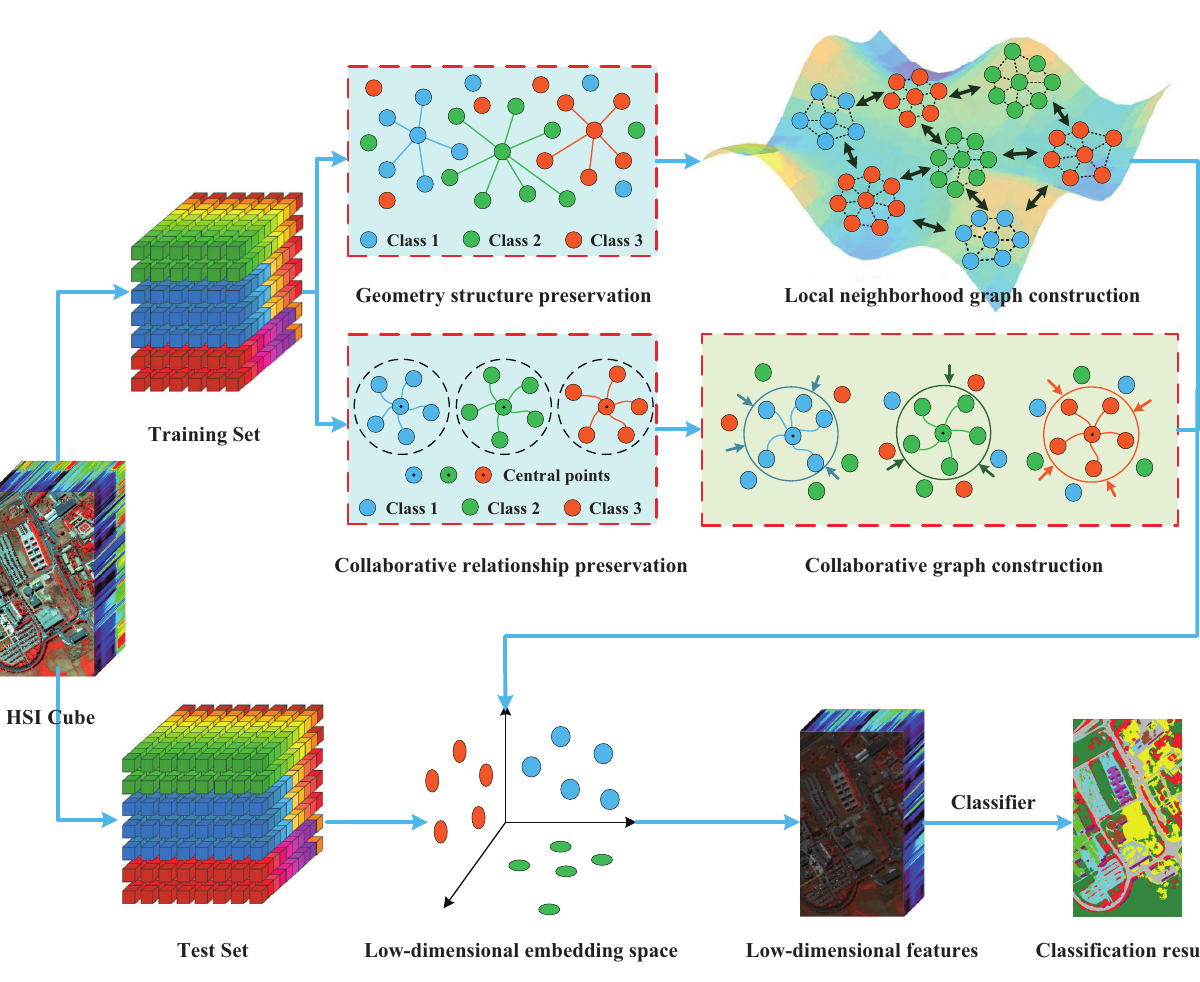
Figure 1. The flowchart of the proposed local constrained manifold structure collaborative preserving embedding (LMSCPE)